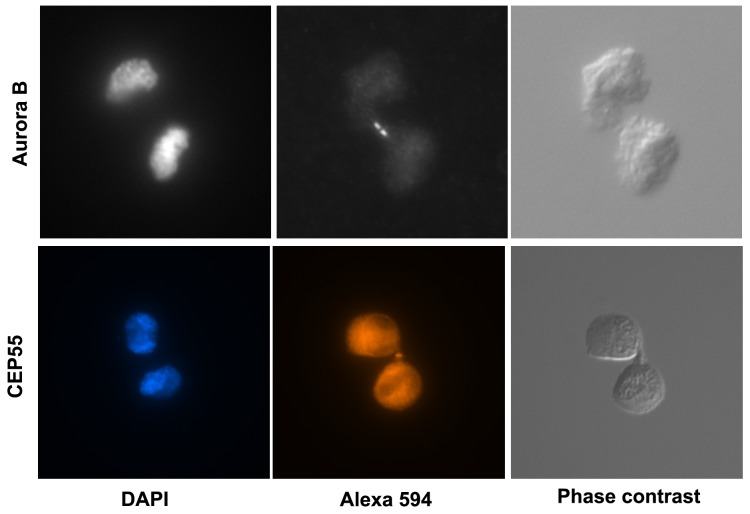
Cytokinesis proceeds to late stages in suspension culture.GD25 M-cells were incubated in suspension for 1.5 hours and then immuno-stained for aurora B and CEP55 as described in the Method section.